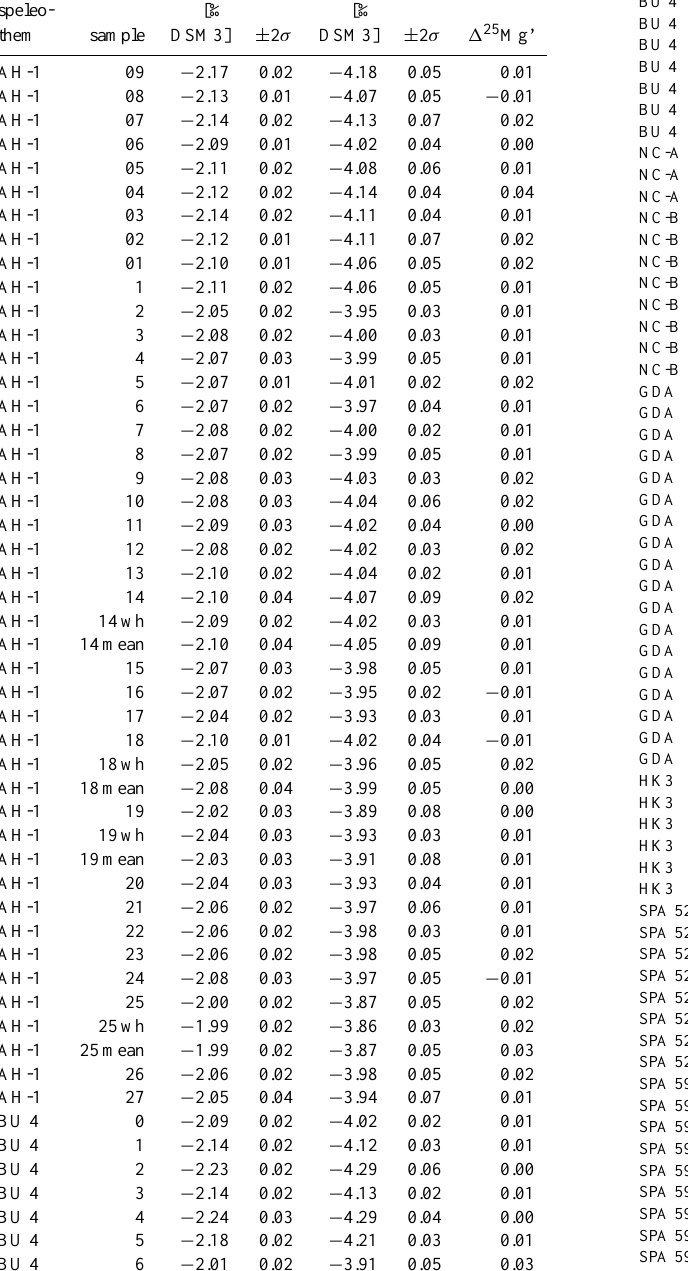
Table 2. Magnesium-isotope values of all speleothem samples. Re- peated analyses are marked “wh” and mean values are indicated “mean”. 1 25 Mg’ data were calculated using the equations of Young and Galy (2004) in order to document the accuracy of analytical re- sults. AH-1: 36 samples (July to August 2007), BU 4: 23 samples (February to March 2011), NC-A/NC-B: 3/6 samples (January to February 2008), GDA: 18 samples (June 2006), HK3: 6